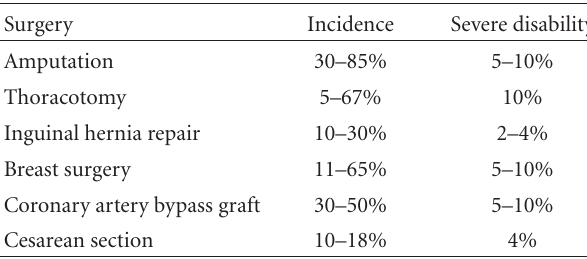
Table 1: Incidence of persistent postsurgical pain and associated disability. Based on data from [37, 71–73].